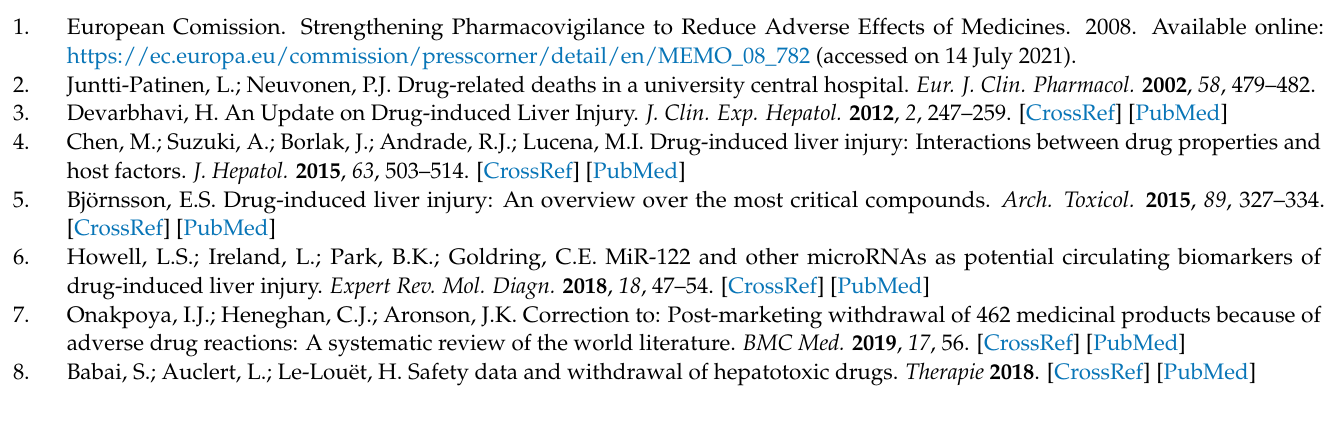
coupling with DGL-122; Table S2: ARG1 calibration curve data; Table S3: miR-122 calibration curve data; Table S4: MFI measurement (in triplicate) of ARG1 and miR-122 in singleplex analysis and seqCOMBO; Figure S2: Levels of ARG1 and miR-122 in a DILI patient when measured via singleplex and seqCOMBO assays. Inter-CV values between singleplex and